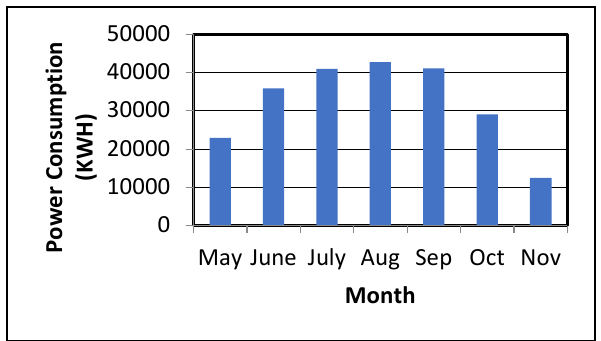
Figure 7 . Energy consumption May2018-Oct 2018 Figure 8 represents the day-wise pattern of energy consumed by Cooling Tower in the months of April and August. Here x-axis denotes the days of month and y-axis denotes the power consumed in Kilo Watt Hour. The analysis of this graph shows that energy consumption in the month of August is nearly similar for each day with very few deviations only, whereas energy consumption in April is comparatively less similar and it shows a